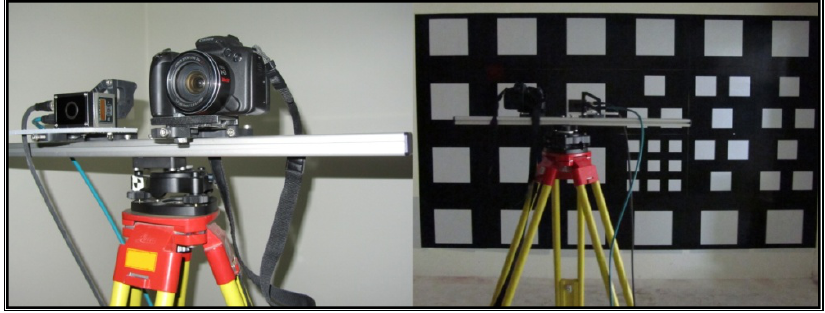
Figure 3. The joint setup of PMD and RGB